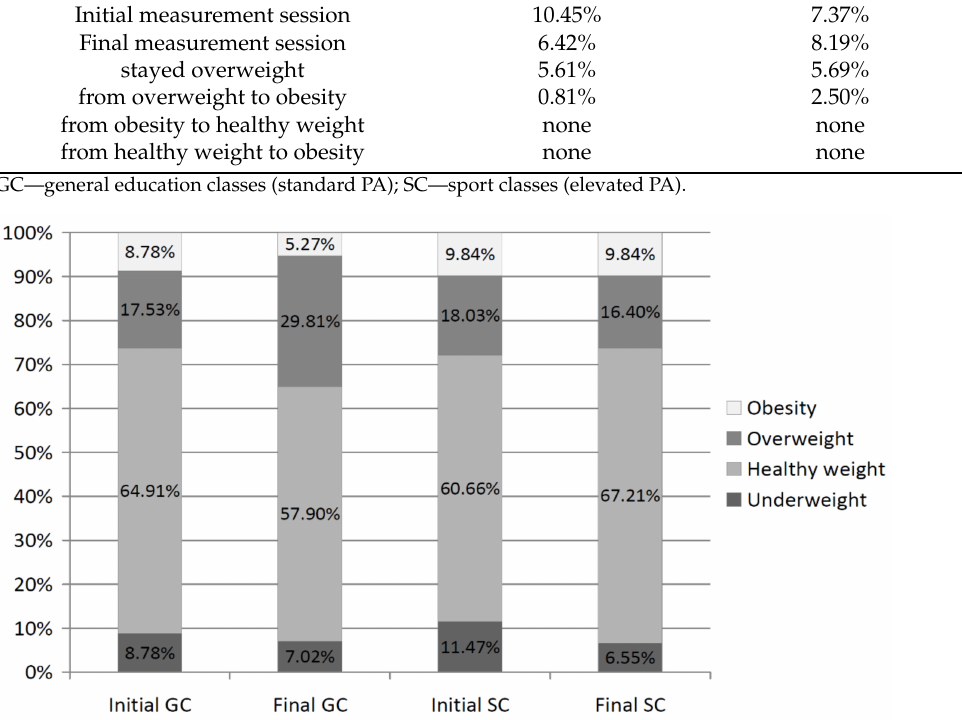
Figure 4. The percentage of girls in particular body mass categories—comparison between the initial and final measurement sessions.